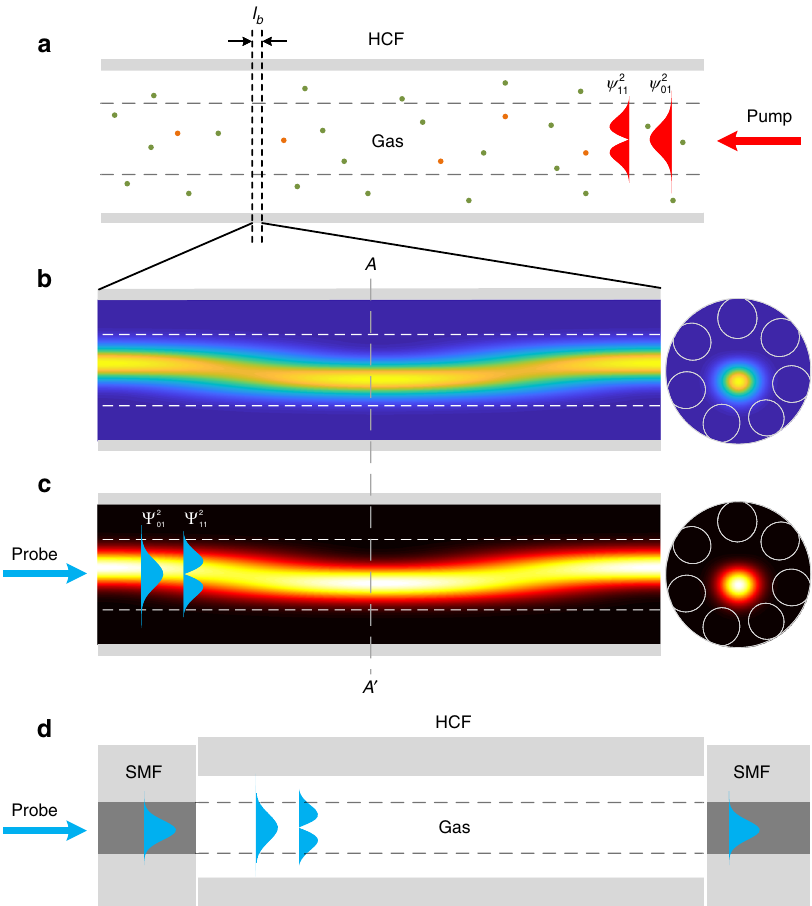
) and LP 11 ( ψ 2 ) modes. 01 11